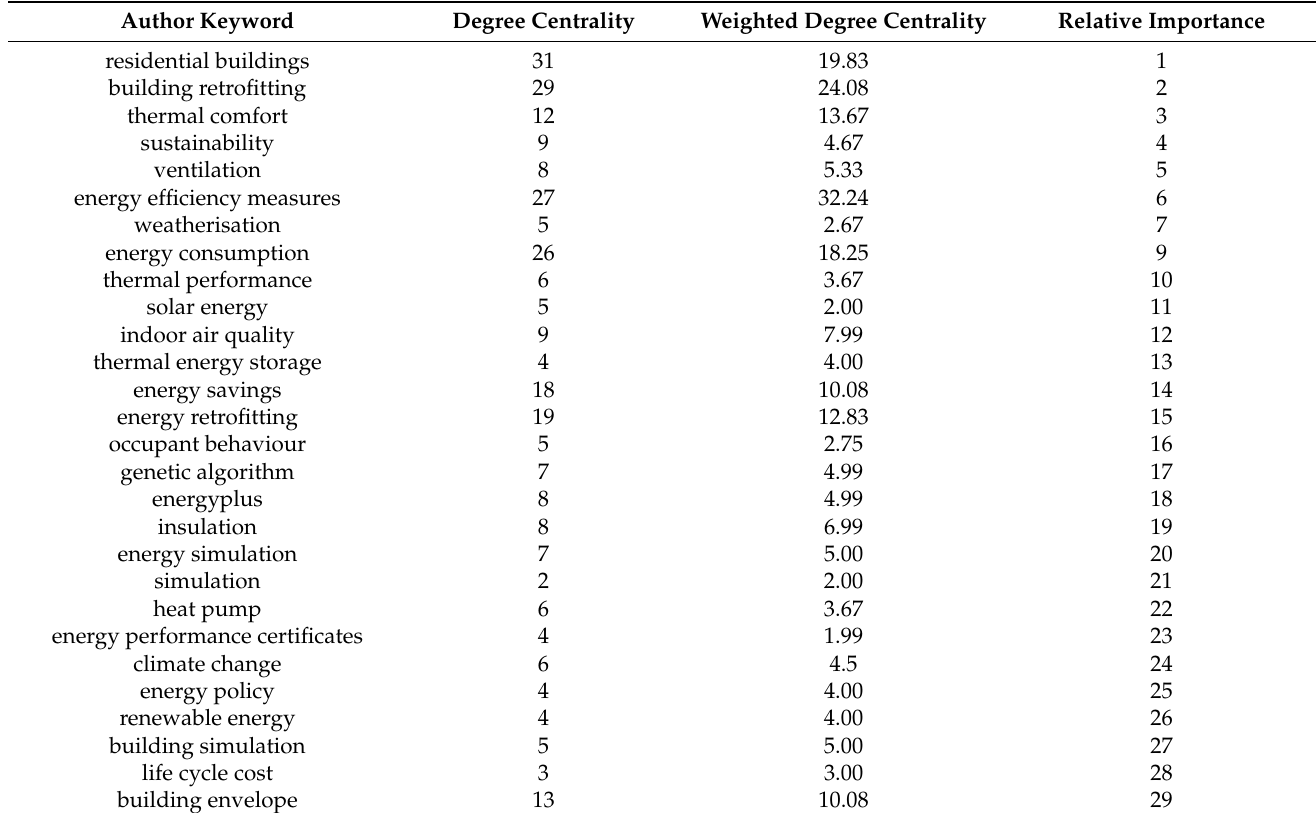
Table 1. The central focus of retrofitting residential